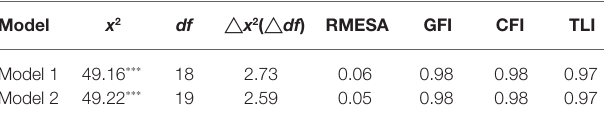
TABLE 2 | Comparison of structural equation models (Model 1 and Model